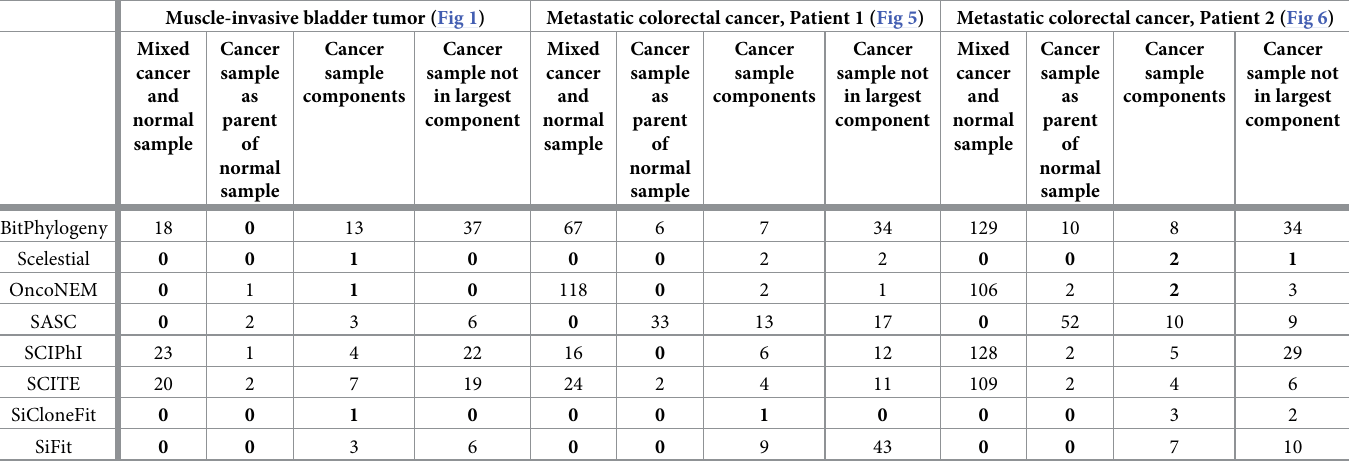
Table 2. Comparison of single-cell phylogenetic trees reconstruction methods on real single-cell genomic datasets. Muscle-invasive bladder tumor (Fig